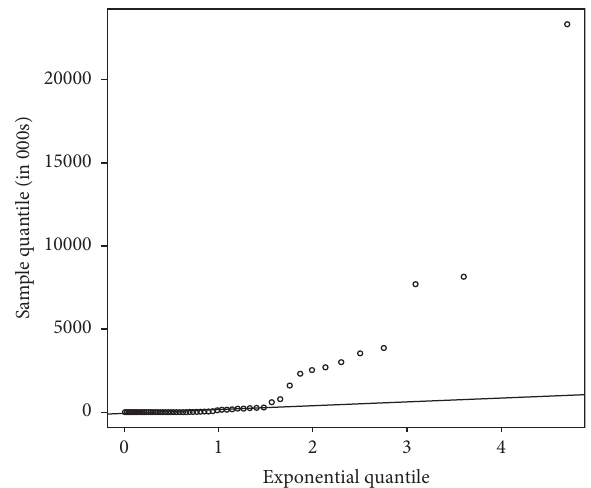
Figure 2: Exponential Q-Q